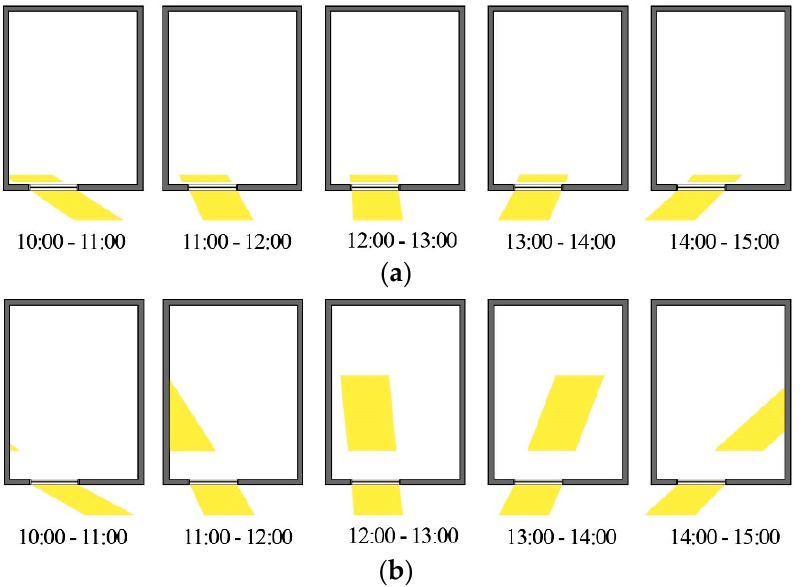
Figure 14. The inflow of natural light by time through the daylighting window in Case 1 (no louver): ( a ) summer and ( b )